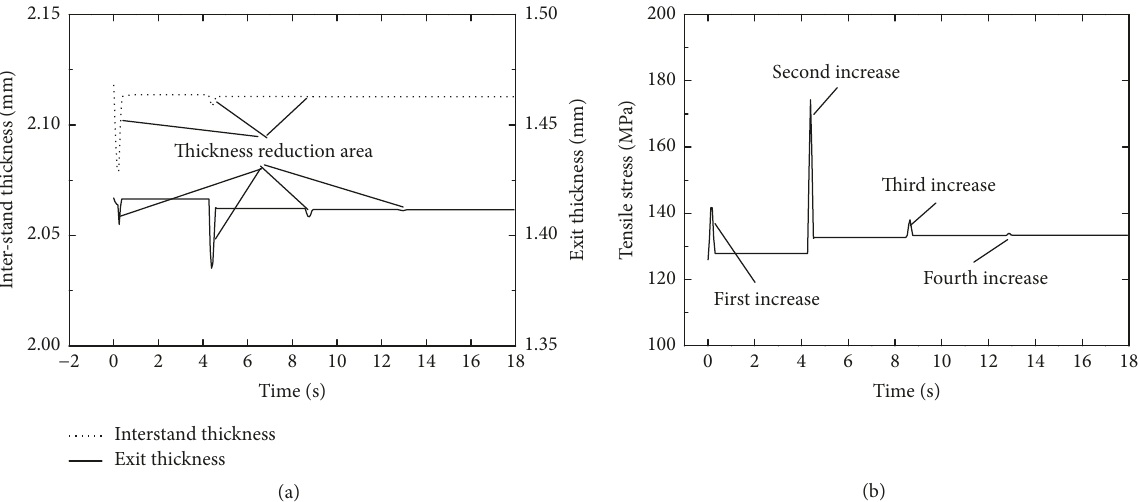
Figure 5: Thickness and tension variation in the startup process with tension established by the entry stand: (a) thickness variation; (b) tensile stress variation.